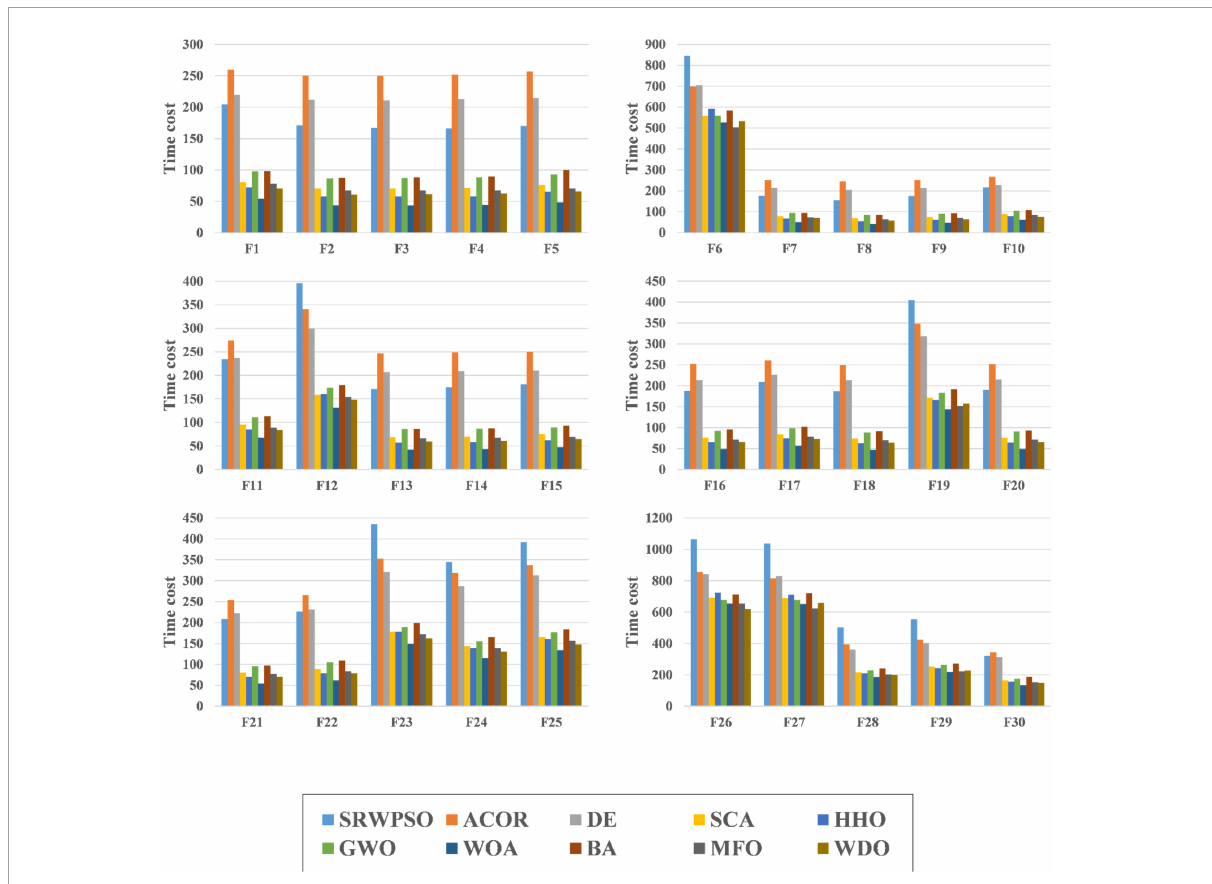
FIGURE9 The time complexity evaluation results of SRWPSO with traditional algorithms.